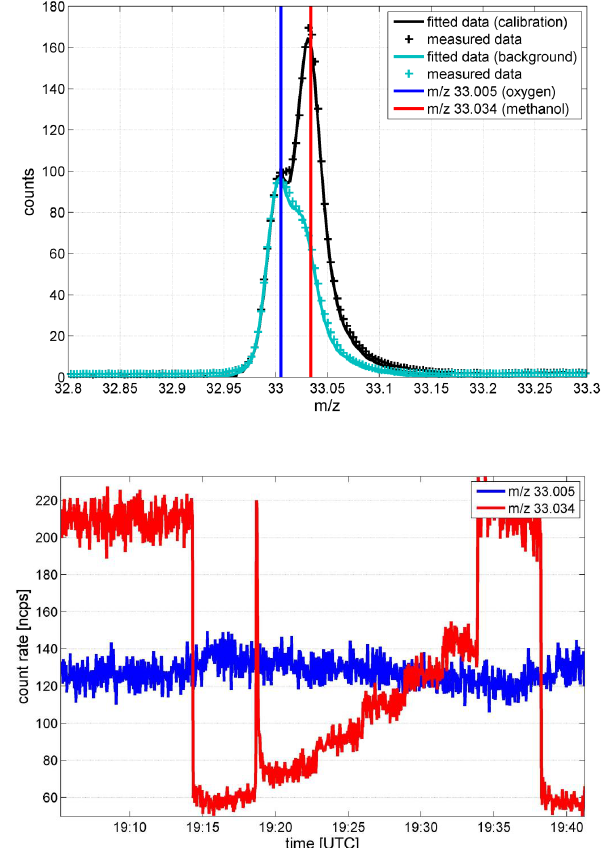
Figure 4. Resolution of isobaric HO 2+ ( m/z 33.005, protonated molecular oxygen) and CH 5 O + ( m/z 33.034, protonated methanol) ions in a 1-minute average mass spectrum (top) and the time series of the two signals obtained during a multi-point calibration with methanol (bottom).